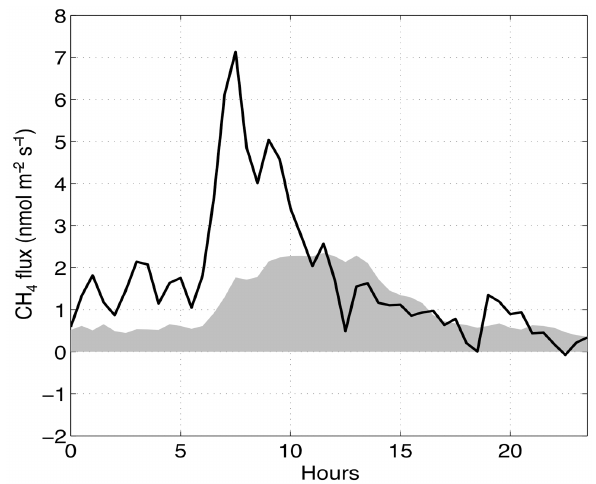
Fig. B1. Averaged diurnal variations of methane fluxes (solid line) and the corresponding detection limit (filled area) for data obtained from January to July 2009.